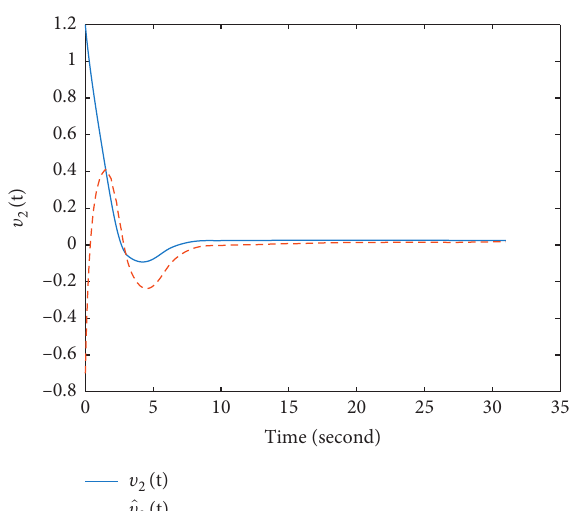
Figure 7: Trajectories of υ